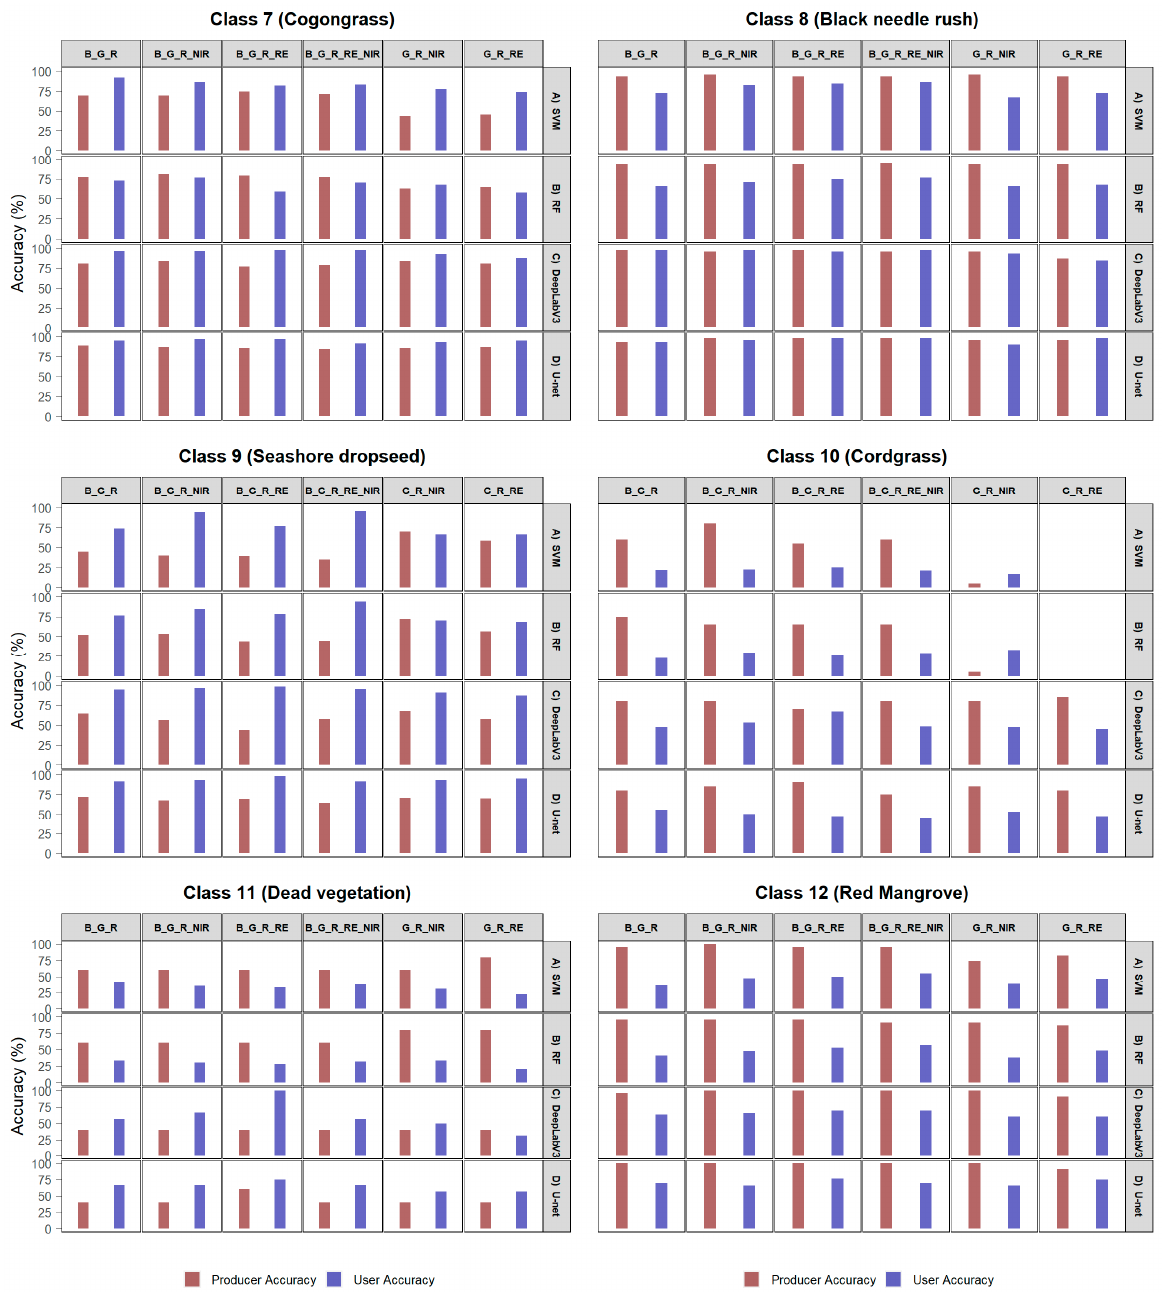
Figure A2. Experiment: EXP1-OSB, producer and user accuracy organized by class and classification method, classes 7 to 12.